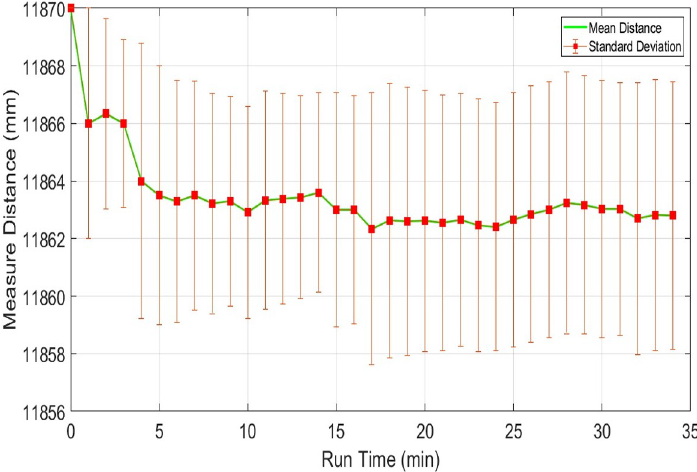
https://doi.org/10.1371/journal.pone.0272063.g017